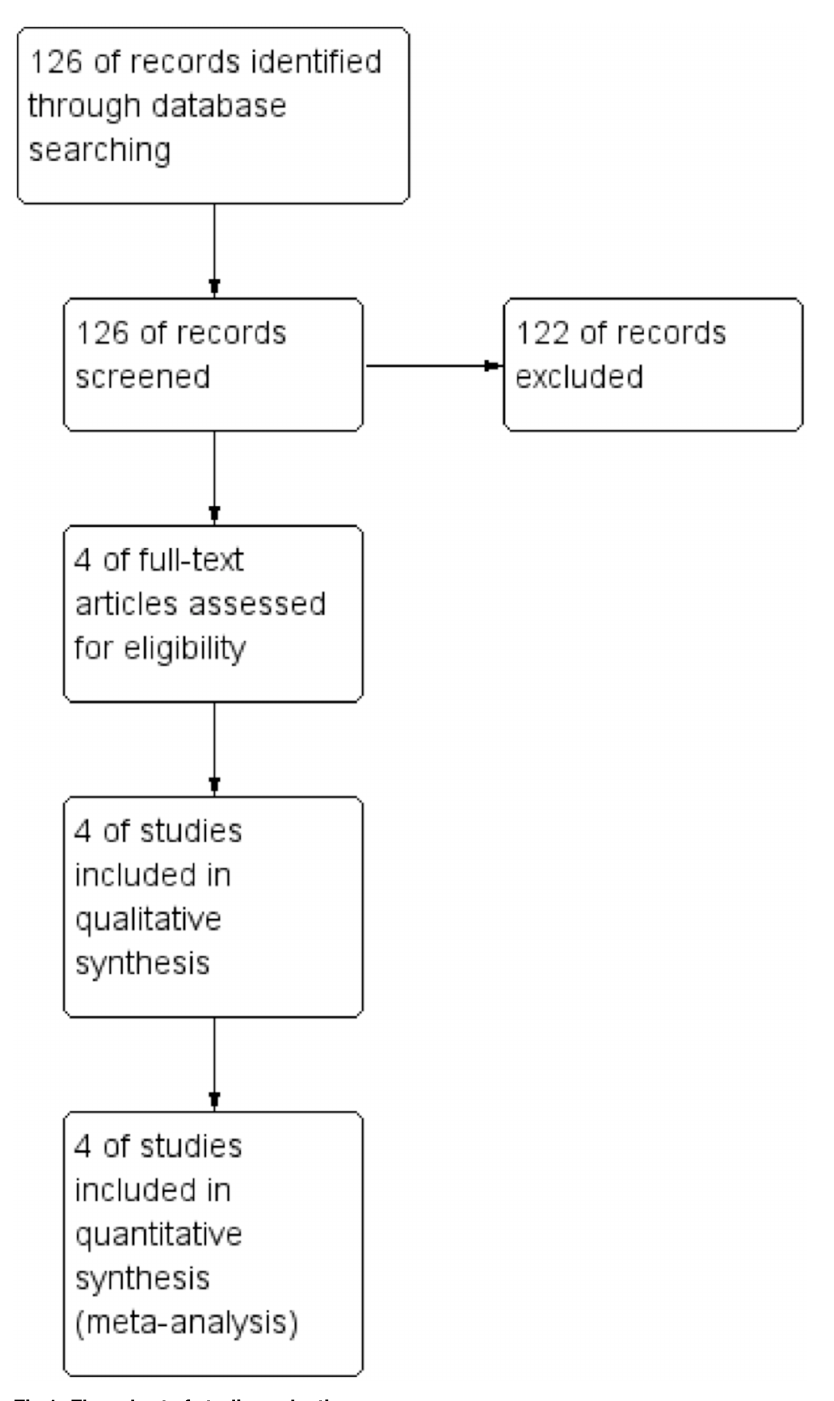
Fig 1. Flow chart of studies